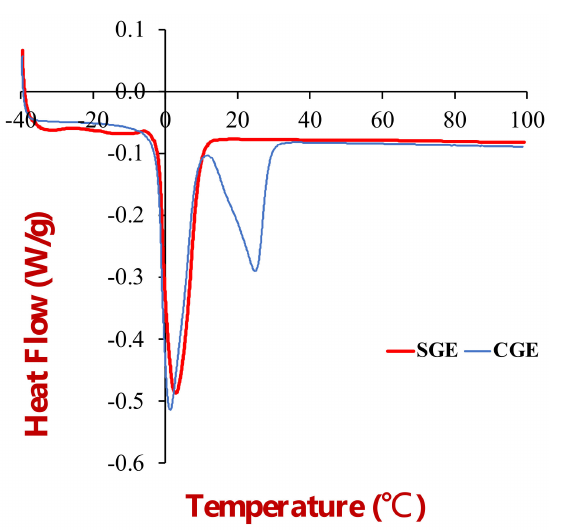
Figure 12. DSC profiles of soybean oil (SGE) and coconut oil (CGE) emulsion gels during heating from − 40 ◦ C to 100 ◦ C.